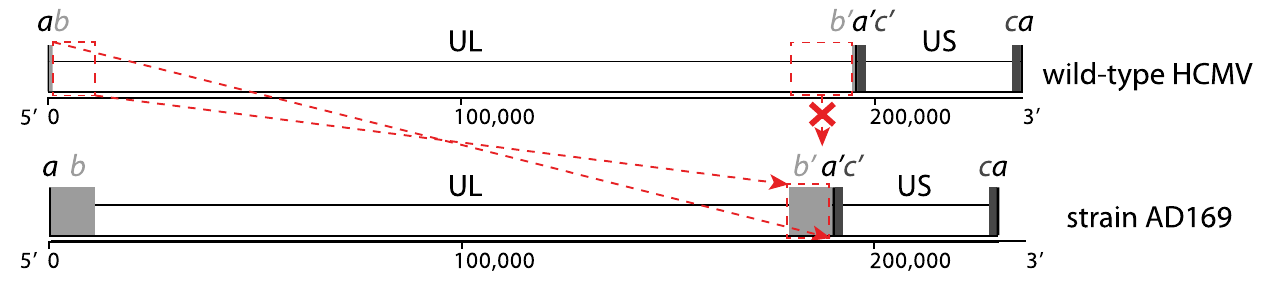
indicated as UL and US. Repeat regions are indicated as a , b and c sequences, where primes designate inverted orientations. Sequences ab and b’a’ correspond to the terminal/internal repeat long (TRL/IRL); sequences a’c’ and ca correspond to the internal/terminal repeat short (IRS/TRS). Top: typical genome arrangement of wild-type strains; bottom: genome arrangement of strain AD169 is given as an example of a laboratory-adapted strain. Genome rearrangements (deletion of UL 3‘ end and replacement by an inverted copy of UL 5‘ end) that have occurred during extensive passaging are indicated in red between the wild-type and laboratory-adapted